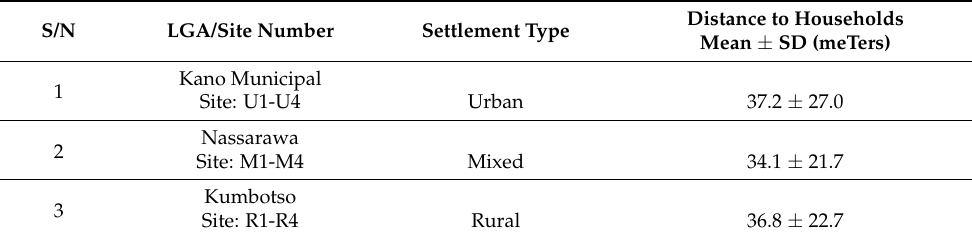
Table 2. Distances between households (HH) and air sampling sites in three local government areas in Kano State, Nigeria.